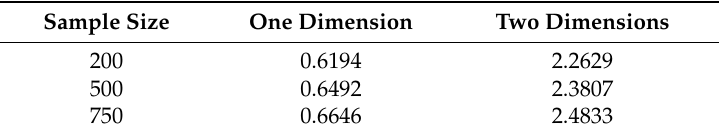
Table 2. Critical values.